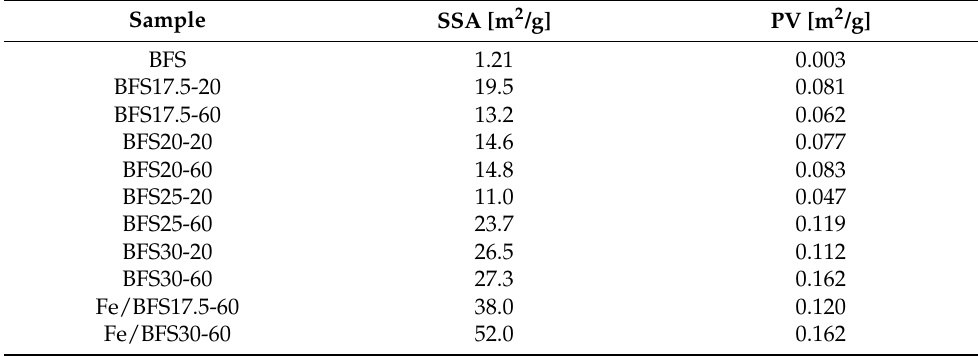
Table 3. BET-specific surface areas (SSA) and pore volumes (PV) of